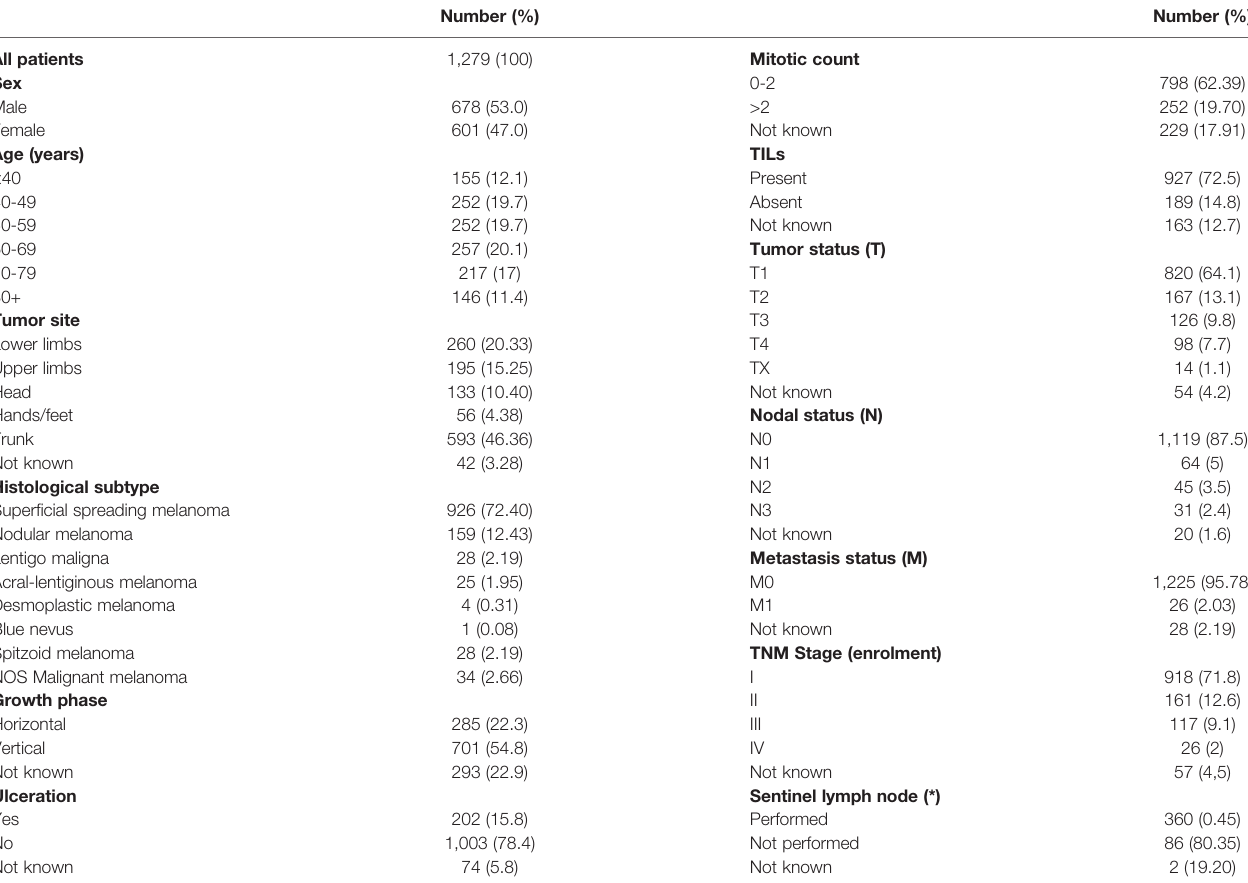
TABLE 1 | Baseline characteristics of the study cohort (NOS, not otherwise speci fi ed; TILs, tumor in fi ltrating lymphocytes). Number (%) Number (%) All